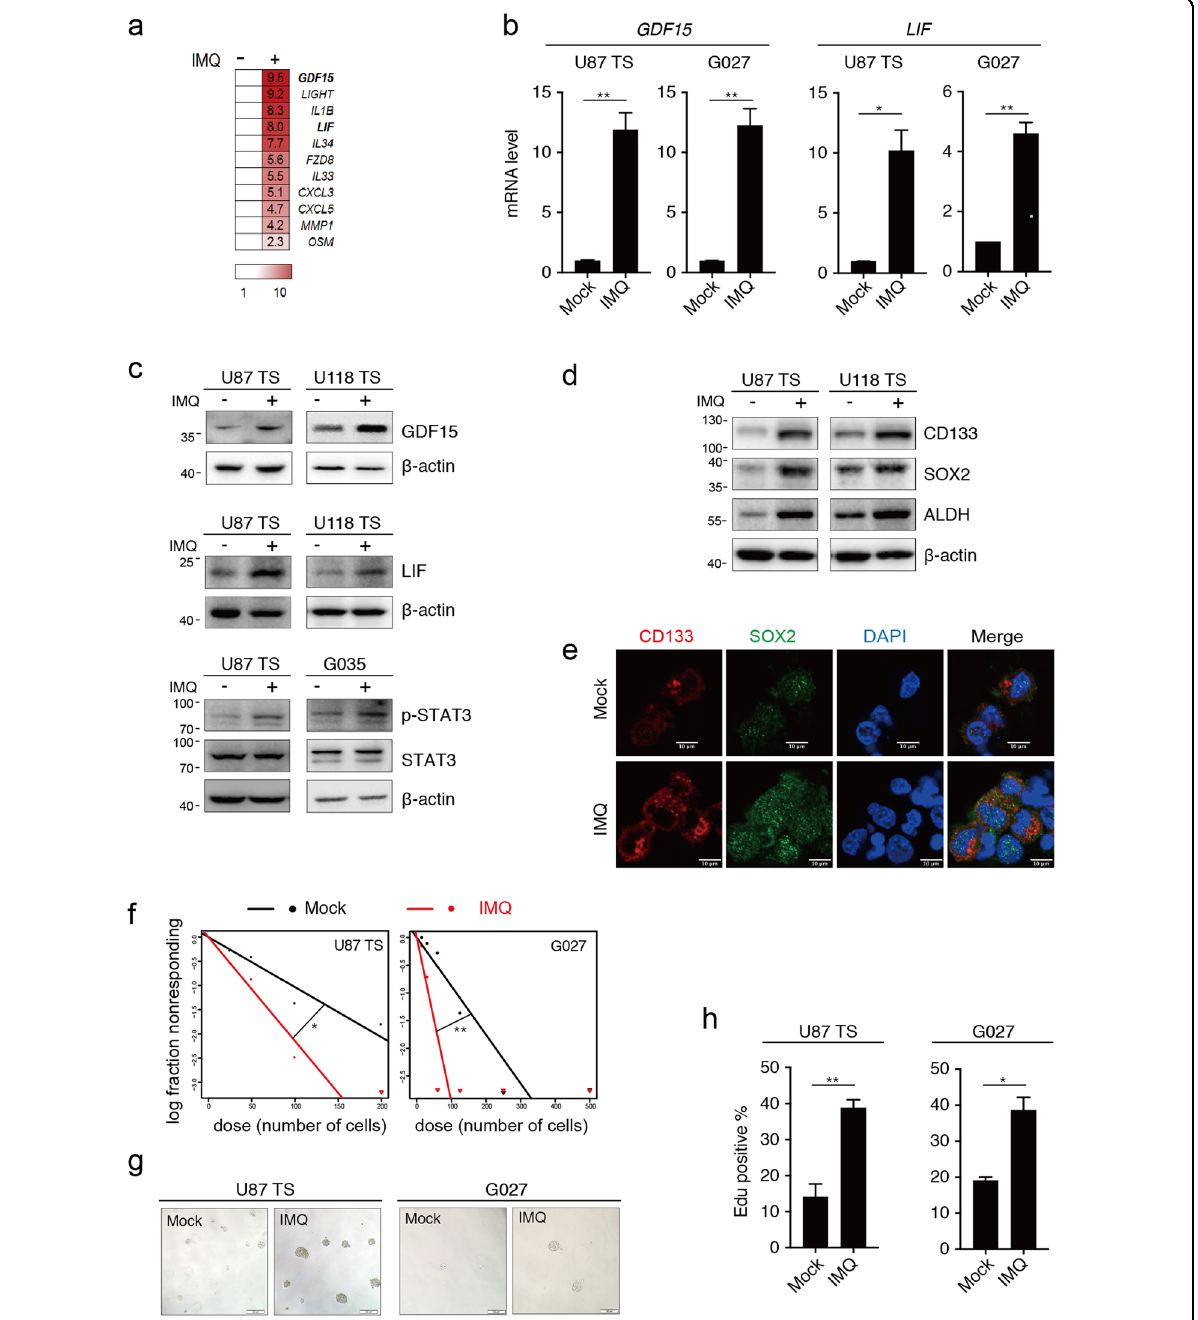
Fig. 3 Imiquimod enhances the GSC-like phenotype. a The upregulation of genes identi fi ed by a transcriptomic analysis was con fi rmed by qRT- PCR in U87 TS treated with 5 μ g/ml imiquimod (IMQ) for 5 days; data were normalized relative to the untreated groups. The scale re fl ects the levels of relative gene expression. b qRT-PCR analysis of GDF15 and LIF expression in U87 TS and G027 cells treated with IMQ. c Immunoblotting analysis of GDF15 and LIF protein expression in U87 TS and U118 TS treated with IMQ, as well as STAT3 and p-STAT3 levels in U87 TS and G035 treated with IMQ. d Immunoblotting analysis of CD133, SOX2, and ALDHA1 (ALDH) expression in U87 TS and U118 TS cells after treatment with IMQ for 5 days. e Immunocytochemical analysis with anti-CD133 and anti-SOX2 in U87 TS cells treated with IMQ for 5 days. Nuclei were counterstained with DAPI. Scale bar = 10 μ m. f Effects of IMQ on the sphere-forming capacity of U87 TS and G027 cells as determined by extreme limiting dilution assay ( n = 12). * P < 0.05, ** P < 0.005; likelihood ratio test. g Representative images of U87 TS and G027 cells after treatment with 5 μ g/ml IMQ for 7 and 10 days, respectively. Scale bar = 100 μ m. h Cell division as determined by the EdU incorporation assay in U87 TS and G027 cells treated with IMQ. Values in b and h represent mean ± s.e.m. * P < 0.05, ** P < 0.005 with unpaired t